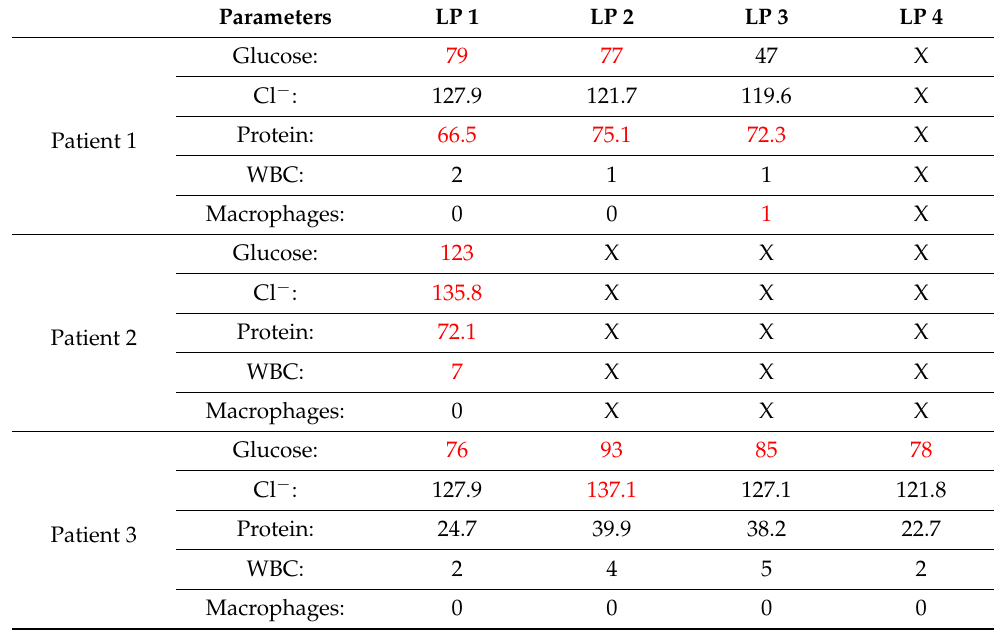
Table 2. Results of the biochemical and cytological analysis of the consecutive CSF samples in all patients.